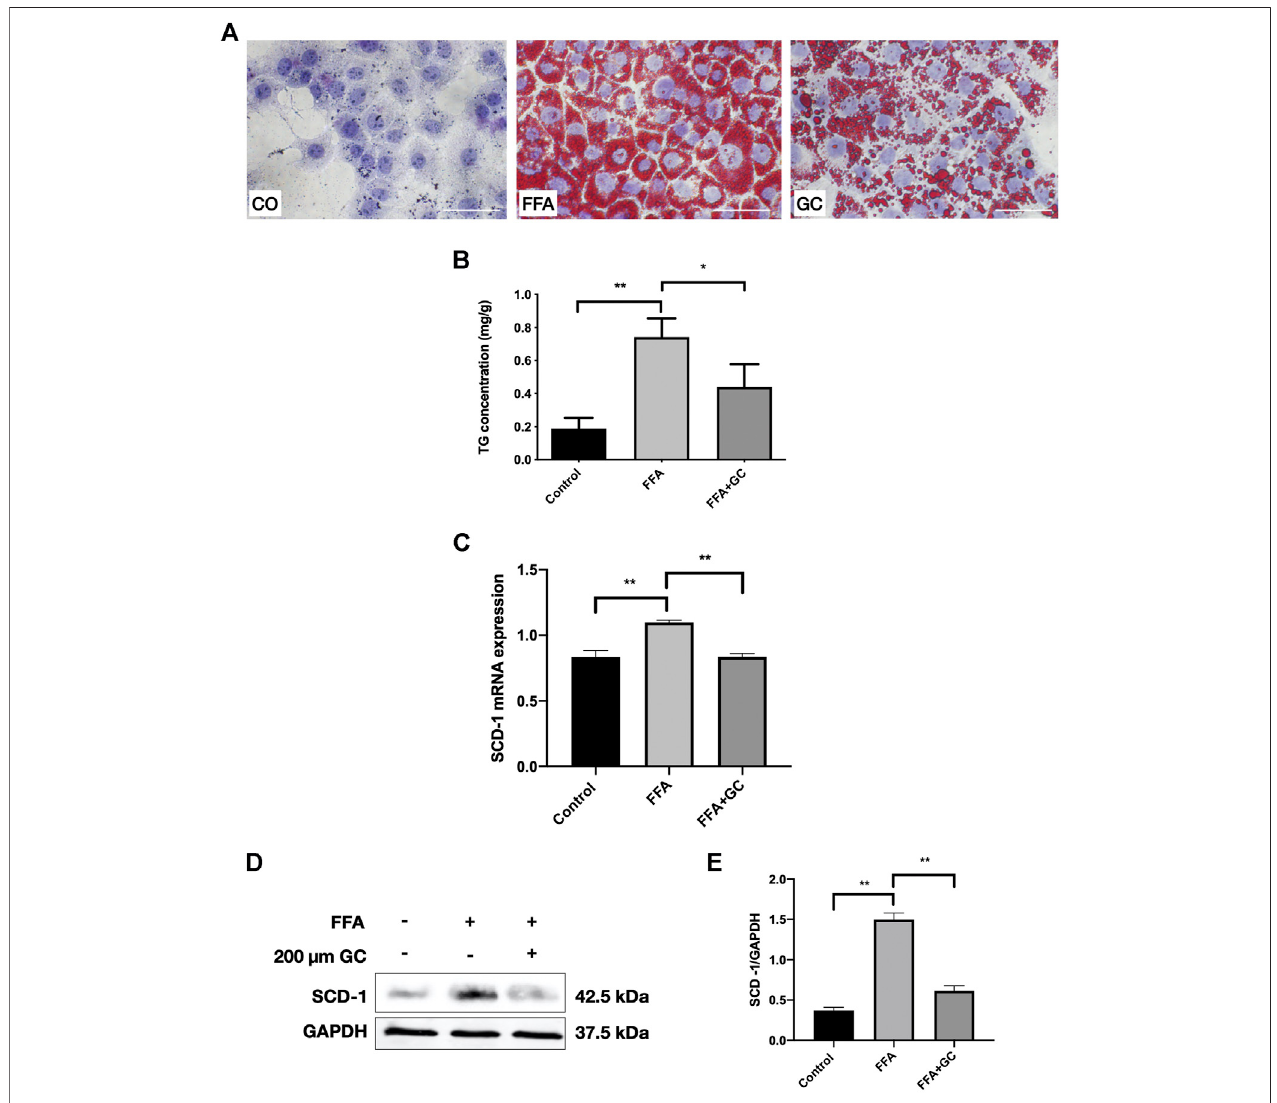
FIGURE 5 | The GC combination ameliorates lipid droplet accumulation and reverses up-regulated SCD-1 induced by free fatty acid (FFA) in AML-12 cells. (A ) Oil Red O staining of AML-12 cells (400 times of magni fi cation). (B) intracellular TG content. (C) SCD-1 mRNA expression in cells was detected by qRT-PCR. (D) SCD-1 protein levels in cells were detected by immunoblotting, and the relative expression levels (E) of proteins were corrected by GAPDH. * p < 0.05, ** p < 0.01.